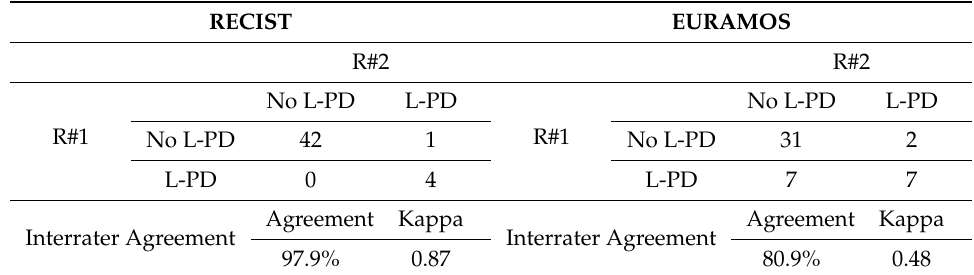
Table 2. Interrater reliability between radiologists; rating progressive disease by Response evaluation Criteria in Solid Tumors (RECIST) and the European and American Osteosarcoma Study